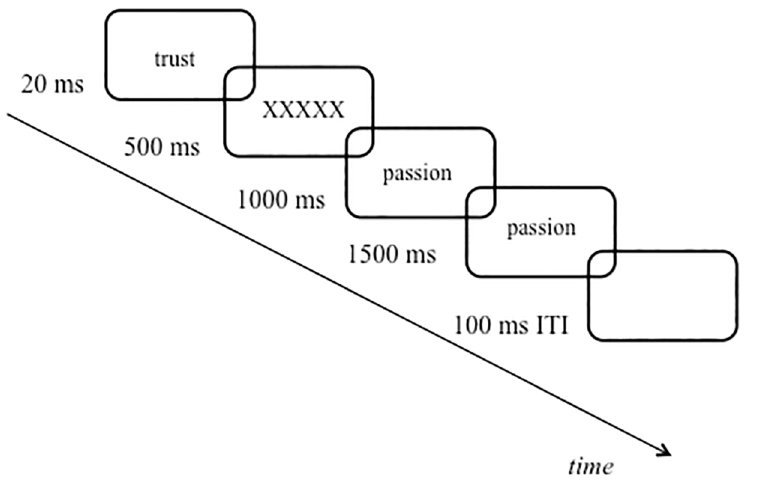
Fig 1. Task sequence. The depiction of the n-back task used in the present study. Here participants were subliminally primed with the secure attachment word (trust), followed by the presentation of the mask, they performed the n-back task with the attachment related words (passion). The task was to respond whether the current word is same or different as in the previous 1/2/3 trial (here: 1-back). In this example the presentation of the word “passion” for the second time would require “same” response as it matches the previously presented item (n-1).. The termination of each trial depended on the response, that is participants had to respond to each word that was presented across trials and each word constituted one trial. Depending on the n-back condition, the word that was identical with the n th back word required the “same” response while the other words/trials required the “different”